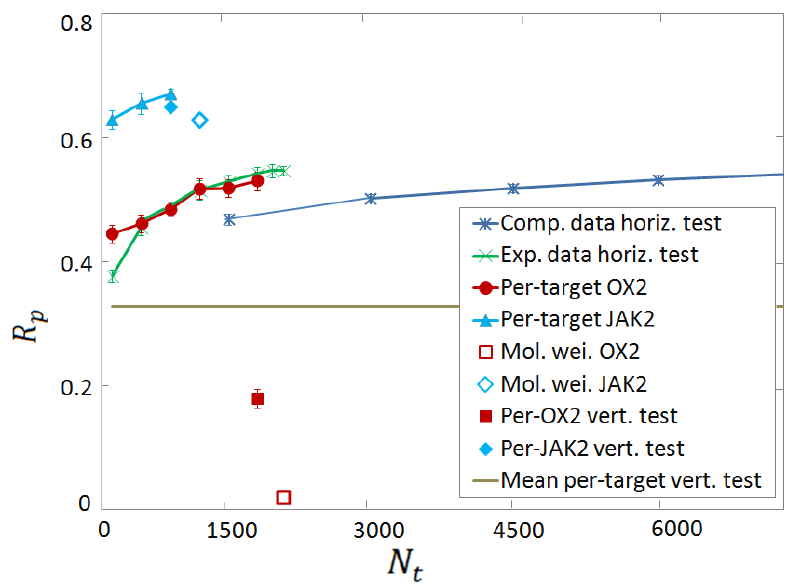
Figure 8. R p accuracy scores as a function of the training set size N t , for two exemplary target proteins, namely, JAK2 (cyan) and OX2 (red). The performances of the per-target FCNN SF’s (cyan triangles for JAK2 and red circles for OX2) are compared to the corresponding scores of the FCNN SFin the vertical test (cyan full diamond and red full square) and of the molecular weight linear regression (cyan empty diamond and red empty square). The large green x’s correspond to the universal FCNN SFin the horizontal test on the experimental database, while the small blue x’s correspond to the analogous test of the computer-generated database. The horizontal gray line represents the average score on the 17 per-target vertical